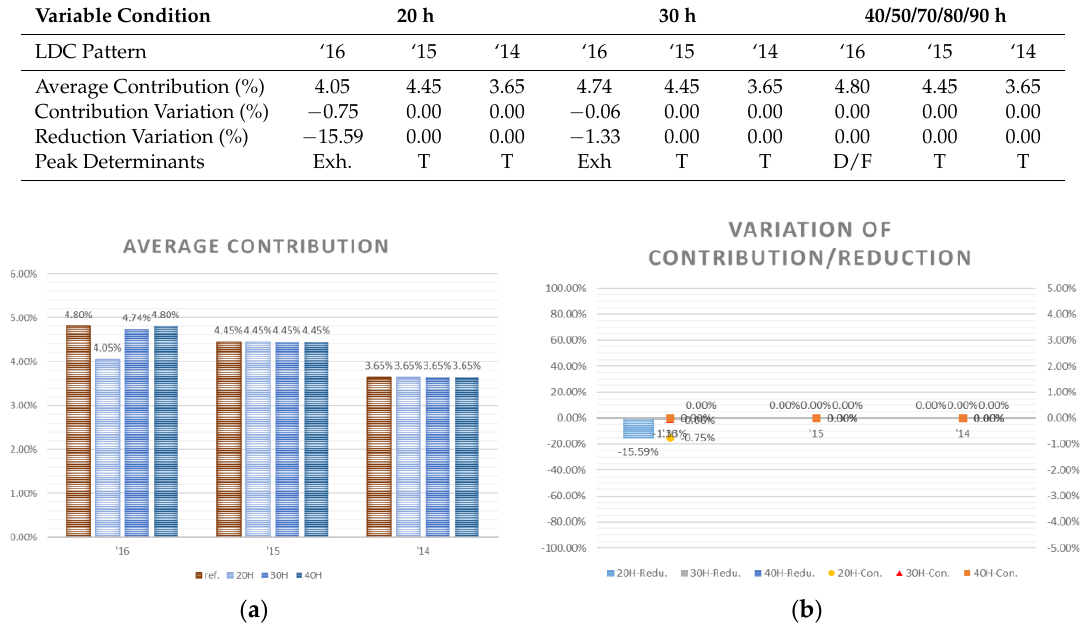
Table 8. Summary of sensitivity simulation results with dispatchable Time.